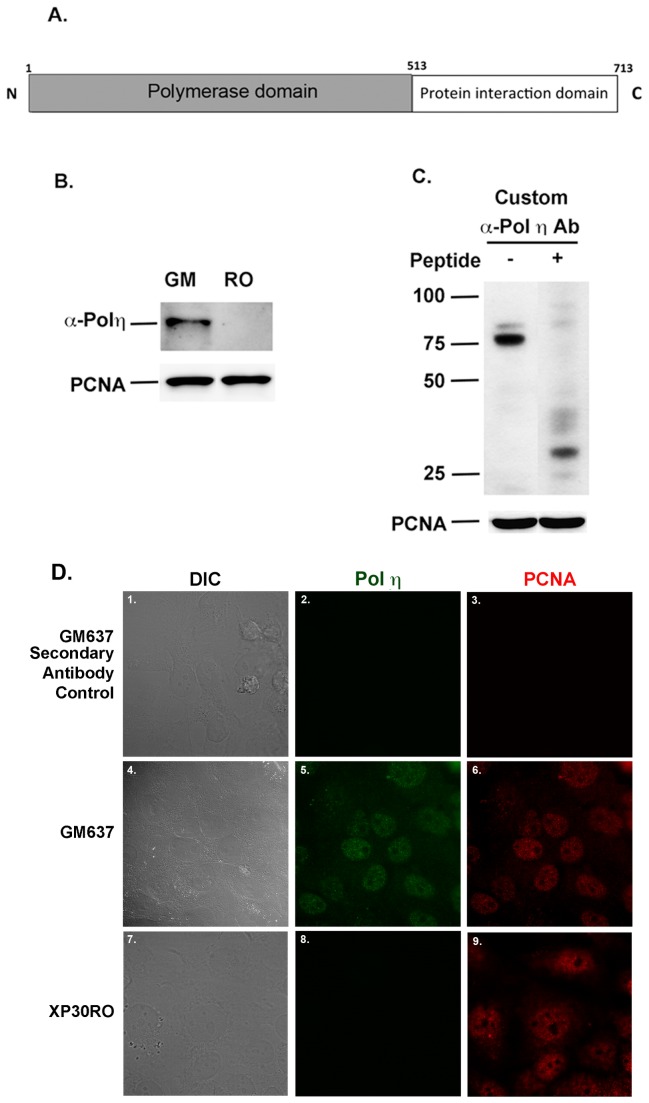
Generation and validation of anti-Pol η antibody.A) The N-terminal fragment of Pol η (highlighted in grey) used for the generation of an anti-Pol η antibody. B) The developed antibody used for the detection of Pol η in the lysates derived from GM637 or XP30RO cells. C) Lane 1. Identification of Pol η from the lysate from human HCT116 cells. Lane 2. Blocking with purified recombinant human Pol η protein. D) 1-3, GM 637 cells probed with secondary antibody alone (D2 and D3). 4-6, GM637 cells probed with anti-Pol η antibody (D5) or anti-PCNA antibody (D6). 7-9, XP30RO cells probed with anti-Pol η antibody (D8) or anti-PCNA antibody (D9).